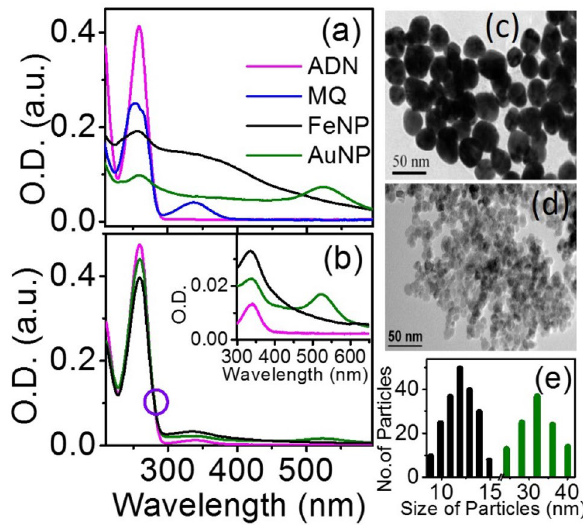
Figure 1. Steady state absorption spectra of ( a ) MQ (0.1 mM, blue), ADN (2 mM, magenta), AuNP (2.8 μg/ml, olive), FeNP (2.8 μg/ml, black) in 5% SDS ( b ) MQ-ADN complex (magenta), Au MQ-ADN (olive) and Fe MQ- ADN (black) in 5% SDS, the inset shows the zoomed view of figure ( b ) from 300 to 600 nm wavelength region. High resolution transmission electron microscopy (HRTEM) image of ( c ) AuNP and ( d ) FeNP and ( e ) their histogram (FeNP-black, AuNP-Olive) over diameter and number of particles.